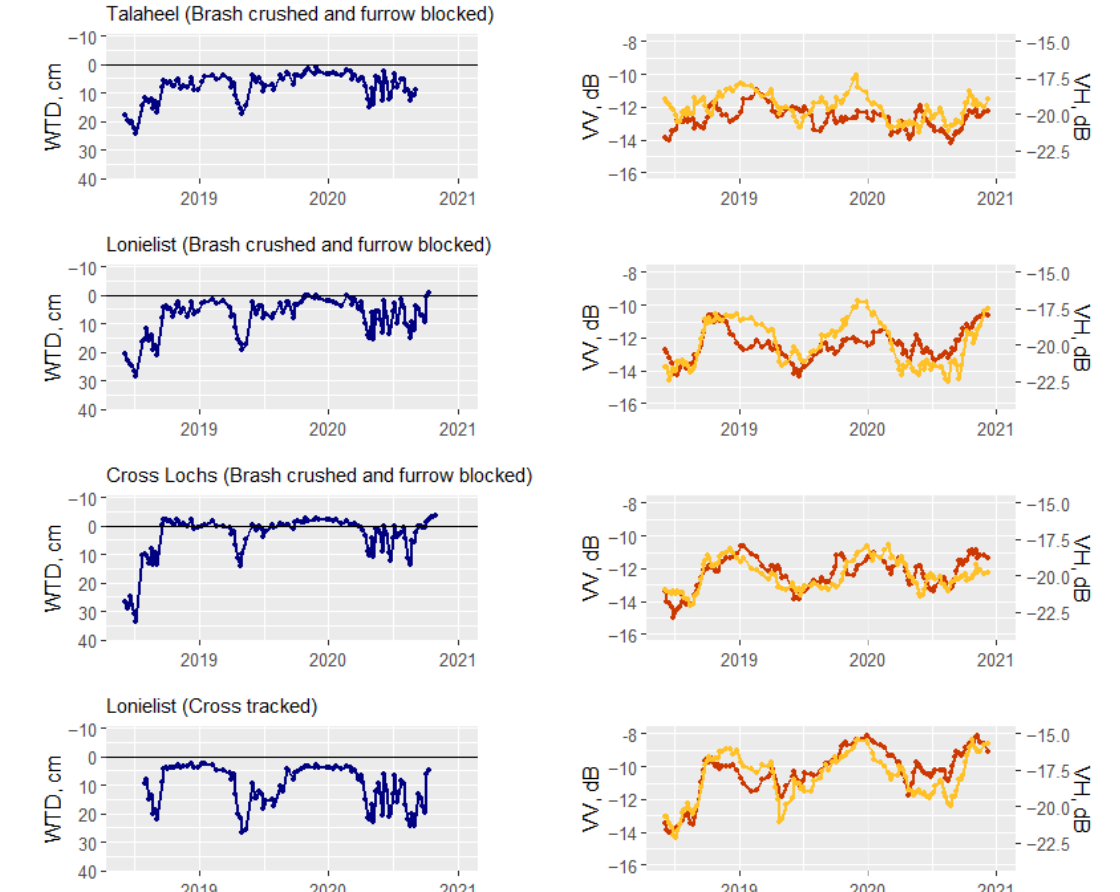
Figure 5. Observed water table depth ( left ) and Sentinel-1 (( right ); VV in red, VH in yellow) time series for sites undergoing more advanced restoration applied (brash-crushing, furrow-blocking, and re-profiling). The black horizontal line indicates the ground surface.